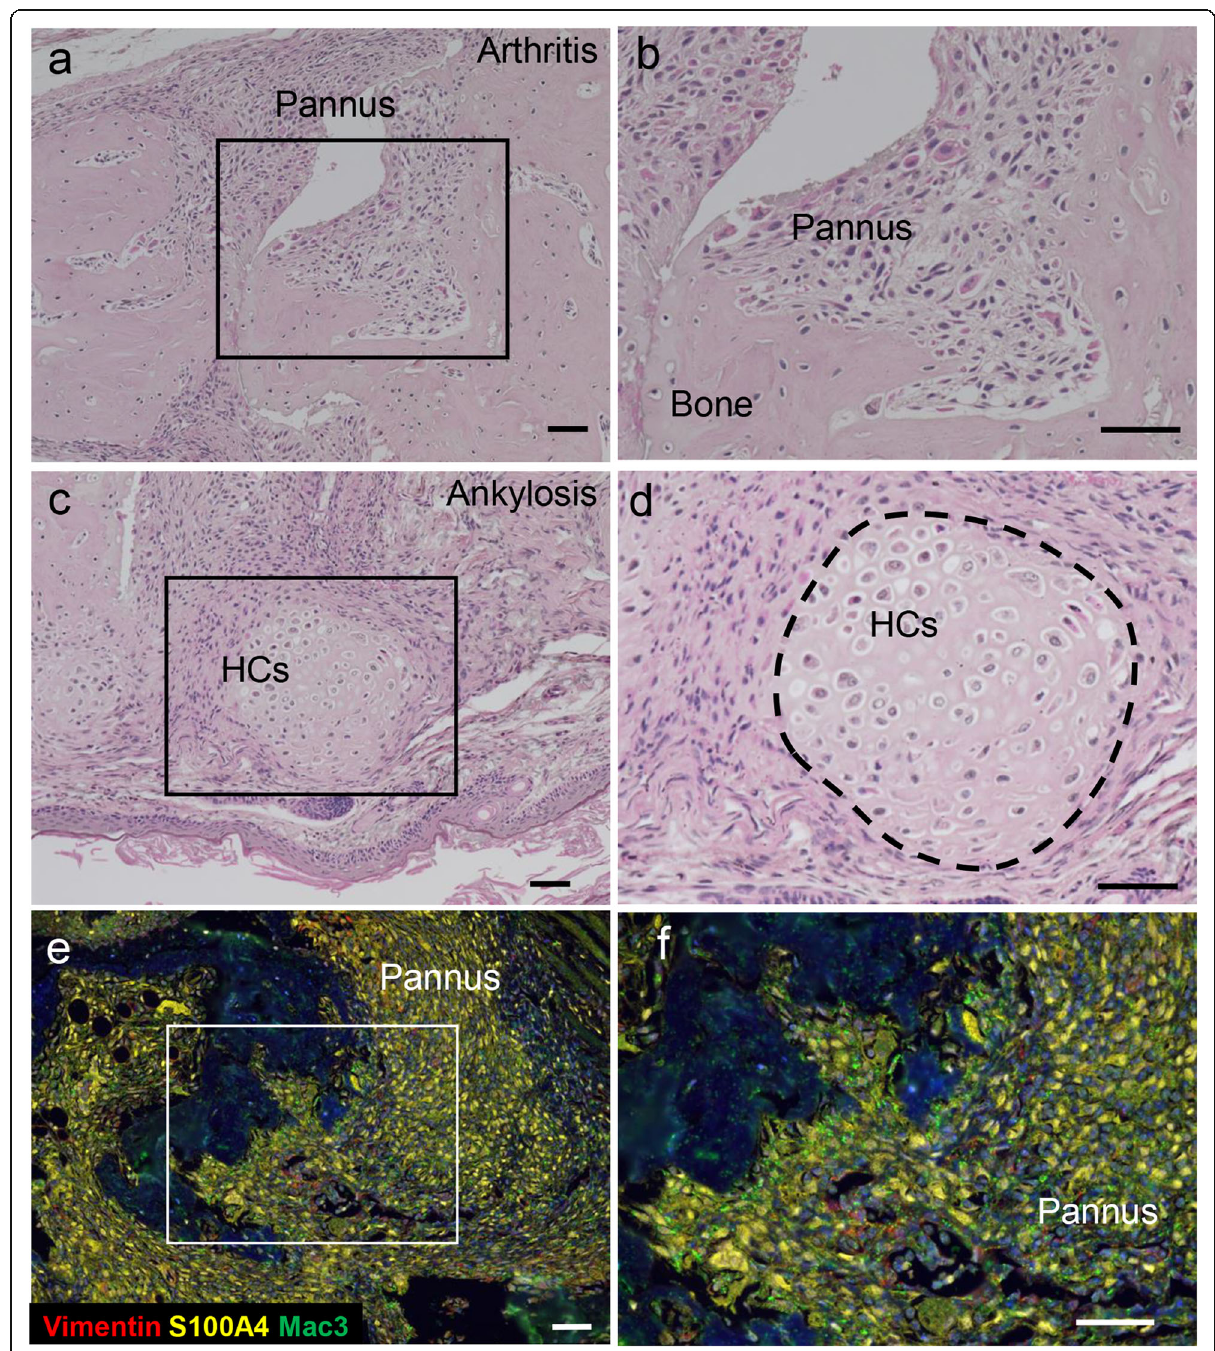
Fig. 2 Pannus formation, bone destruction, and ankylosis in bColII-D1BC mouse [16]. a – d H&E staining for pannus formation and bone destruction ( a , b ) and ankylosis ( c , d ) in bColII-D1BC mouse joints. D1BC mice were injected with a low dose of bColII (0.02 mg/mouse). Following chondrogenesis, hypertrophic chondrocytes (HCs) were localized adjacent to invasive synovial fibroblasts in pannus in D1BC mouse joints. e and f Immunohistochemical staining of vimentin (red), S100A4 (yellow) ,and Mac3 (green) in bColII-D1BC mouse joints. Each box in a, c, and e represents a magnified area from each right panel. Scale bar = 50 μ